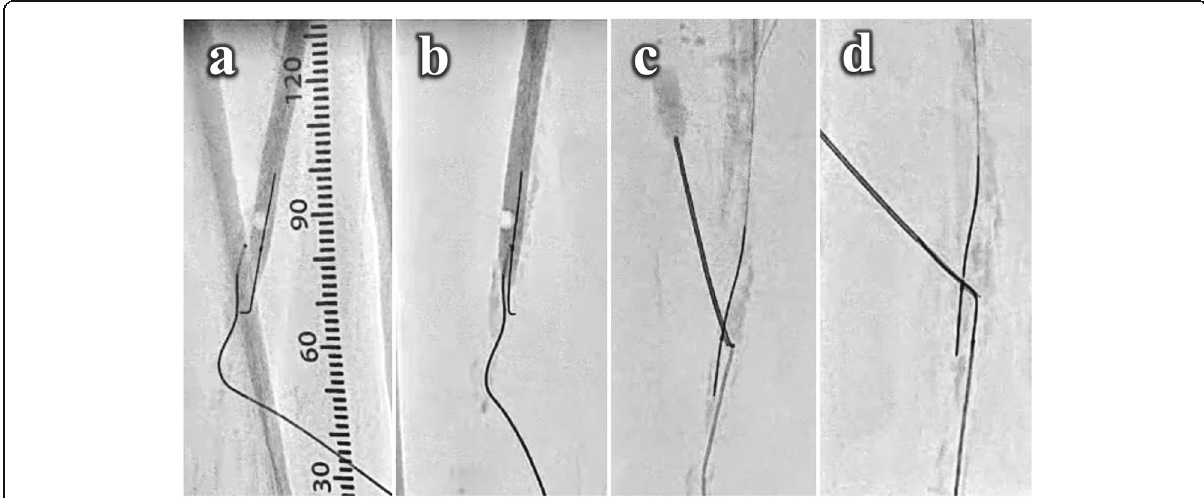
Fig. 2 The process of the “ needle rendezvous ” of the “ needle re-entry ” technique. A . The retrograde microcatheter in the distal lumen below the dilated antegrade 5.0-mm balloon in the subintimal plane was confirmed in ipsilateral view. B . These devices were overlapped in contralateral view. C . An 18-gauge needle was inserted from the distal thigh to the dilated balloon. After confirming a balloon rupture by the needle penetration, the needle was continued to advance to meet the retrograde guidewire tip. D . A retrograde 0.014-in. guidewire was carefully